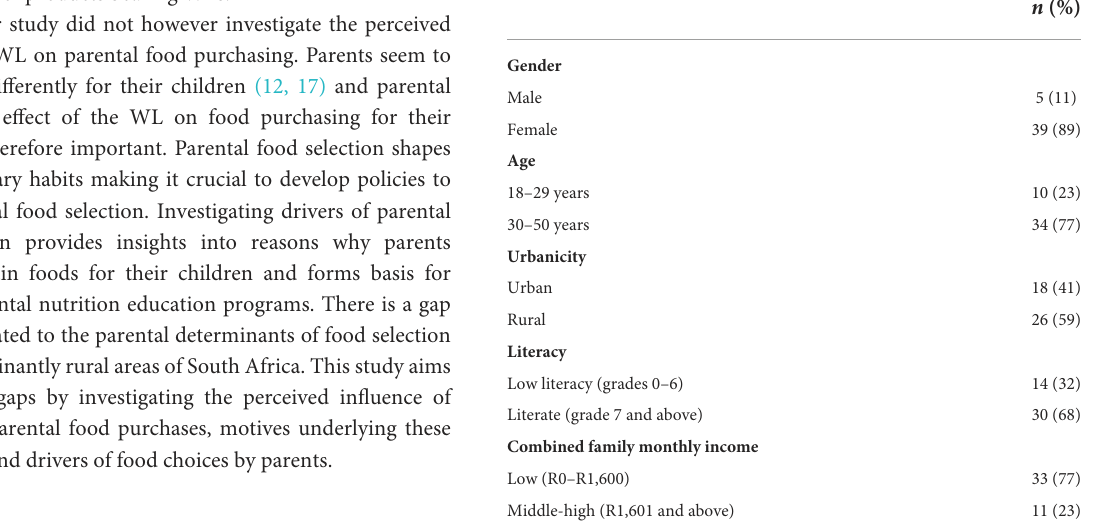
TABLE 1 Socio-demographic characteristics of parents (n = 44)